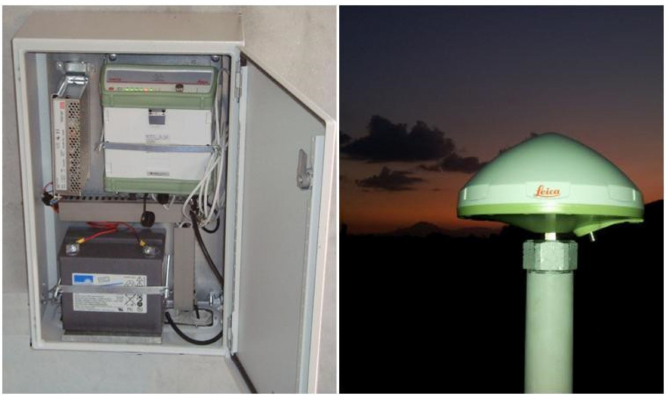
Figure 8. Permanent GNSS station equipment ( left ) and GNSS receiver antenna ( right ).